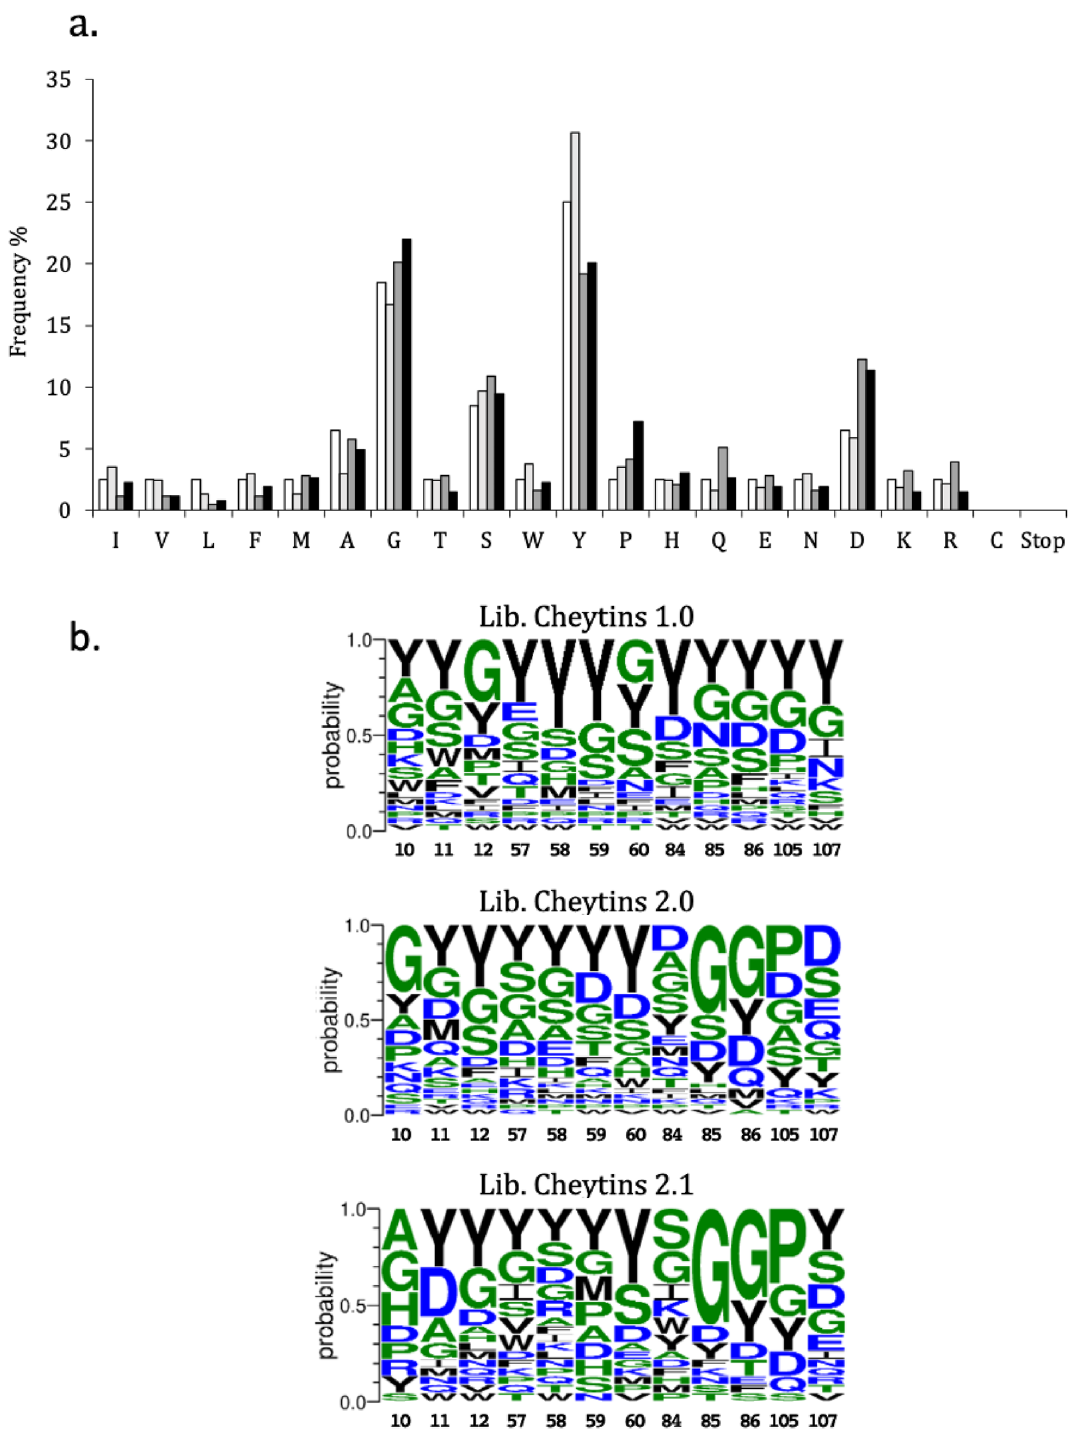
Figure 5. Sequence analyses of the 3 Cheytins libraries 1.0, 2.0 and 2.1. ( a ) Sequence diversity of the three libraries Lib-Cheytins 1.0 (light grey), Lib-Cheytins 2.0 filtrated by P2 (middle grey) and Lib-Cheytins 2.1 (Black) compared to the expected diversity (white). The experimental amino acids frequency of the randomized positions compared to the expected frequencies from the coding scheme (white). ( b ) Logo representation of the 12 randomized positions in the three libraries. The alignments of individual sequences are shown as a sequence LOGO using the sequence numbering found for randomized positions in each library as the abscissa. The sequence diversity ( a ) and the alignments ( b ) were performed with randomly selected protein sequences from the 3 different libraries. Thirty different protein sequences (corresponding to 12 * 30 = 372 diversified amino acid) encoding variants of Lib-Cheytins 1.0, thirty- six different protein sequences for Lib-Cheytins 2.0 (432 diversified amino acid), and twenty-two different protein sequences (264 diversified amino acid) for Lib-Cheytins 2.1 were used for these analyses. The frequency was calculated by considering the number of a particular amino acid found in the totality of the diversified amino acids in the set of sequences of each library. For example, for library 1.0, thirty sequences were considered for this study. In each sequence, there are twelve randomized residues, corresponding in total to 12 * 30 = 372 amino acids. In this sample, we found thirteen prolines. The frequency of proline corresponds to (13/372) * 100 =